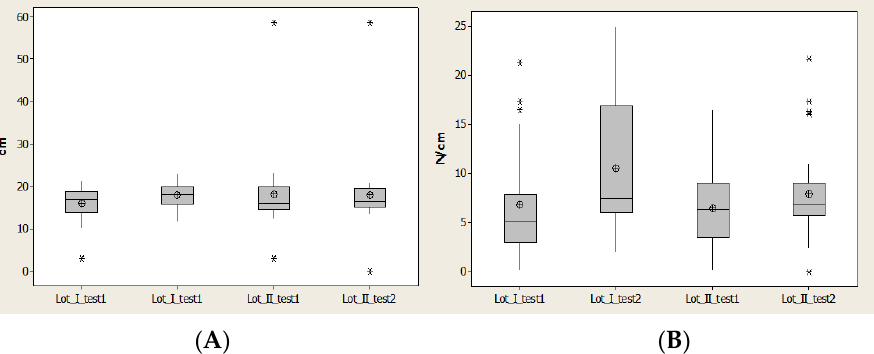
Figure 9. Plantar region lateral heel: ( A ) contact area, ( B ) Pmax distribution. * Small disperssion. ** High distribution